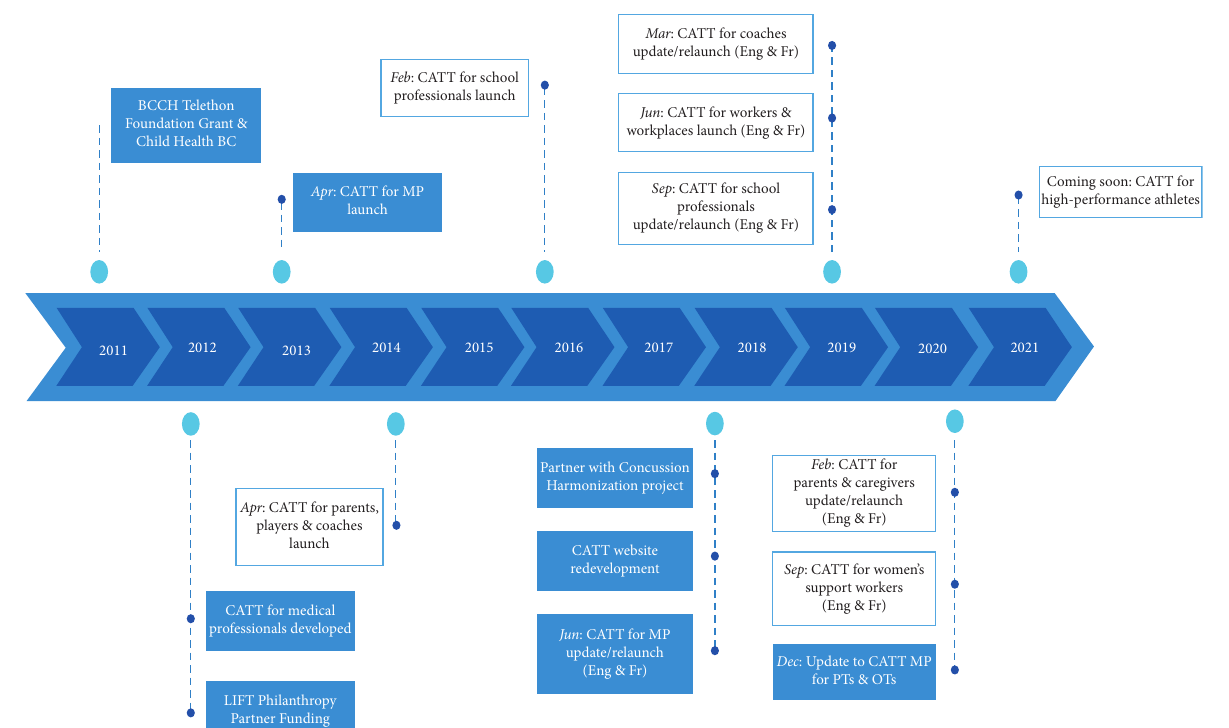
Figure 1: Schematic representation of the timeline of important milestones in the CATT